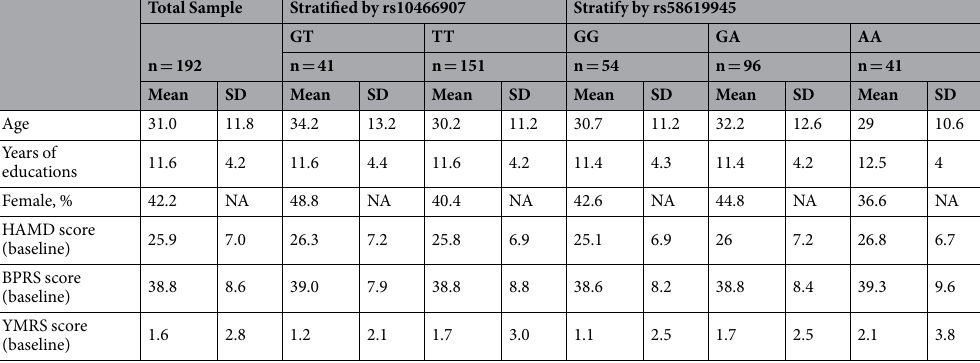
Table 1. Demographic and clinical characteristics for the participants. Abbreviation: NA: not applicable; HAM- D: Hamilton depression Rating Scale; BPRS: Brief Psychiatric Rating Scale; YMRS: Young Mania Rating